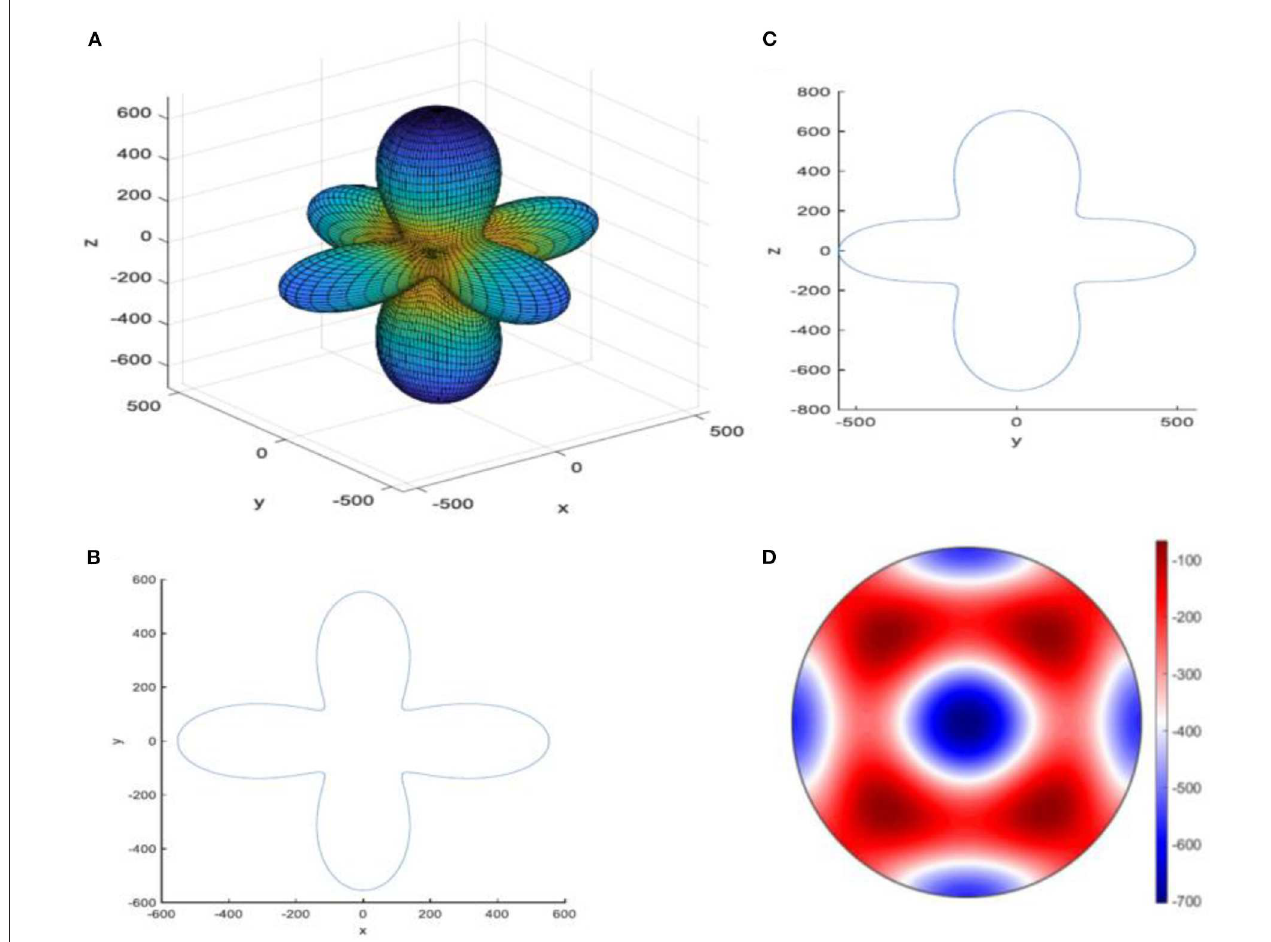
FIGURE 8 | (A) 3D plot, (B) xy 2D plot, (C) yz 2D plot, and (D) the magnitude of the largest value of the piezoelectric tensor of aluminum nitride crystal.